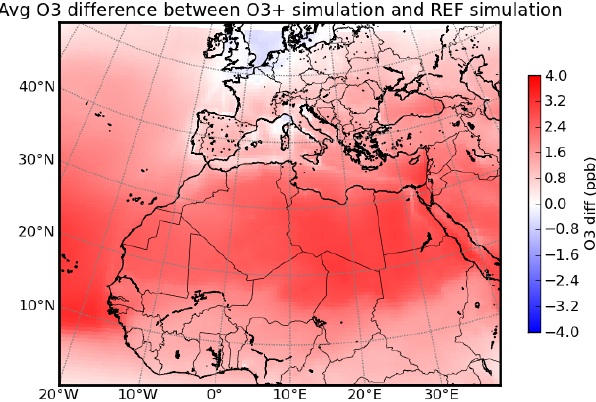
Figure 20. Difference (ppb) in the concentration of ozone in the lowest model layer between the O3+ simulation and the REF simu-